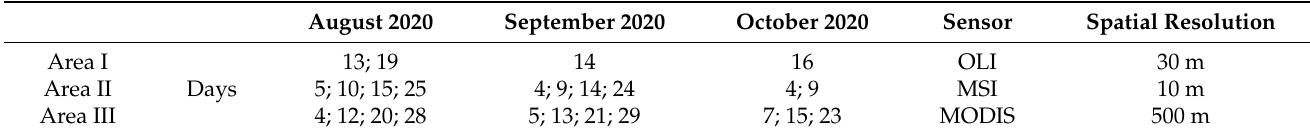
Table 2. Dates of the images considered in the experiments.